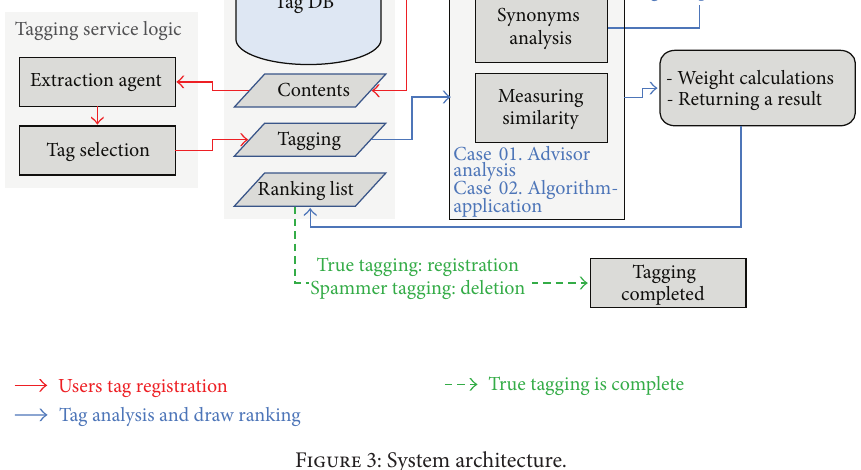
Figure 3: System architecture.